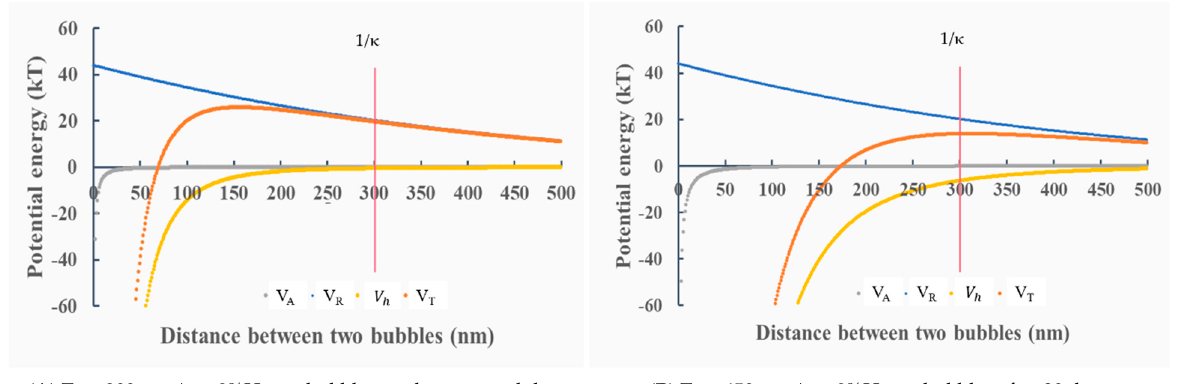
Figure 8. Total potential energy V T as a function of the distance between two nanobubbles at − 24 mV zeta potential on the prepared day for Ar + 8%H 2 ( A ) and − 12 mV after 30 days for Ar + 8%H 2 nanobubbles ( B ) in deionized water. ( A ) Two 200 Ar + 8%H 2 gas bubbles on the prepared day, ( B ) two 450 nm Ar + 8%H 2 gas bubbles after 30 days.